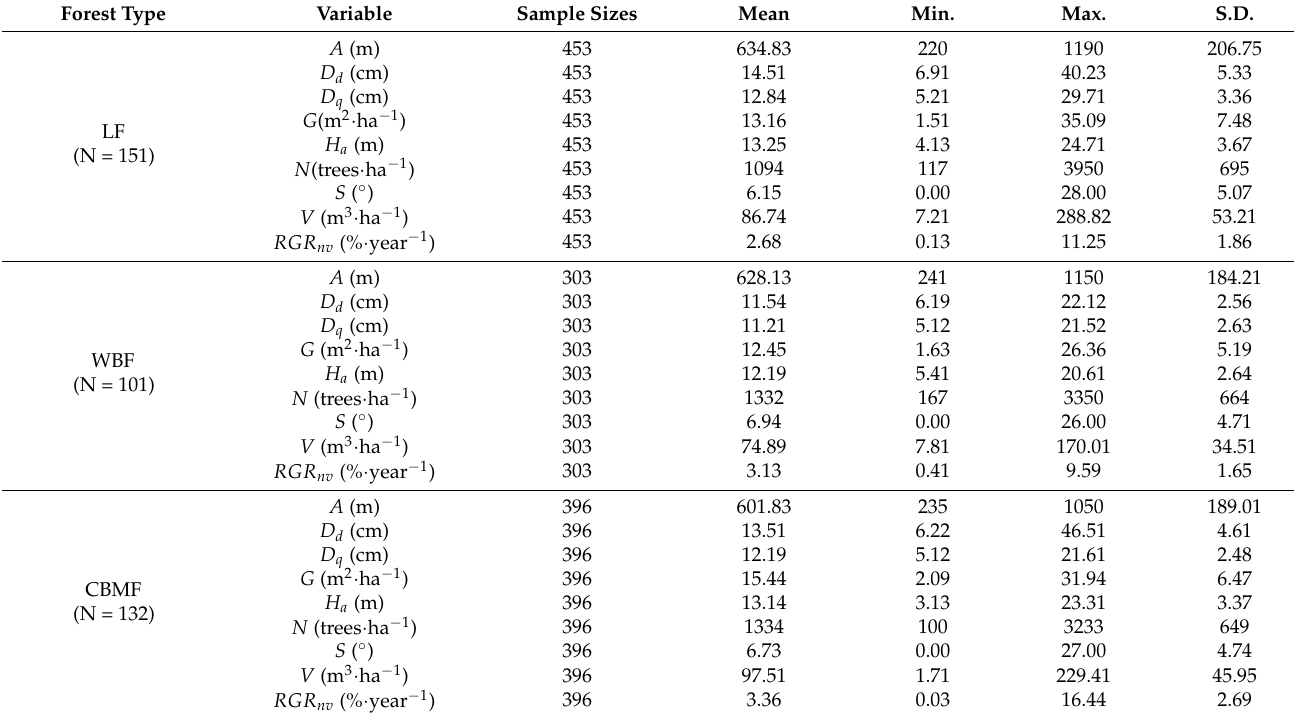
Table 2. Descriptive statistics of variables of the three forest types in the eastern Daxing’an Mountains, Northeast China. Forest